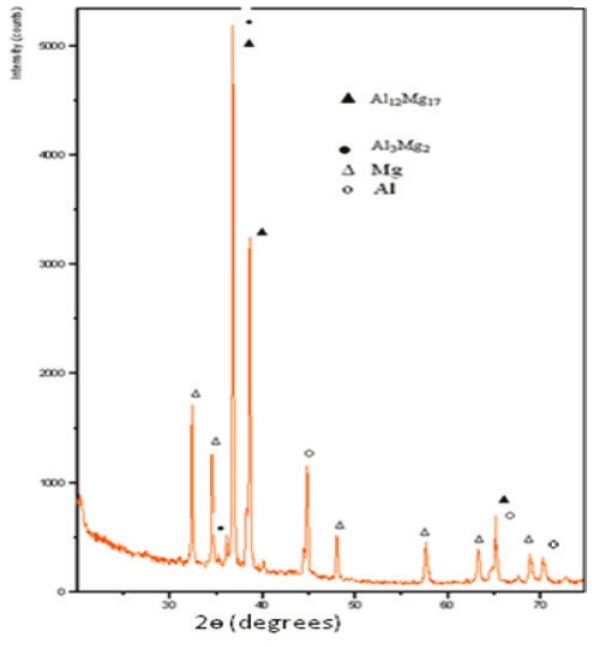
Figure 12: X-ray diffraction pattern of the sample S6 (Figure